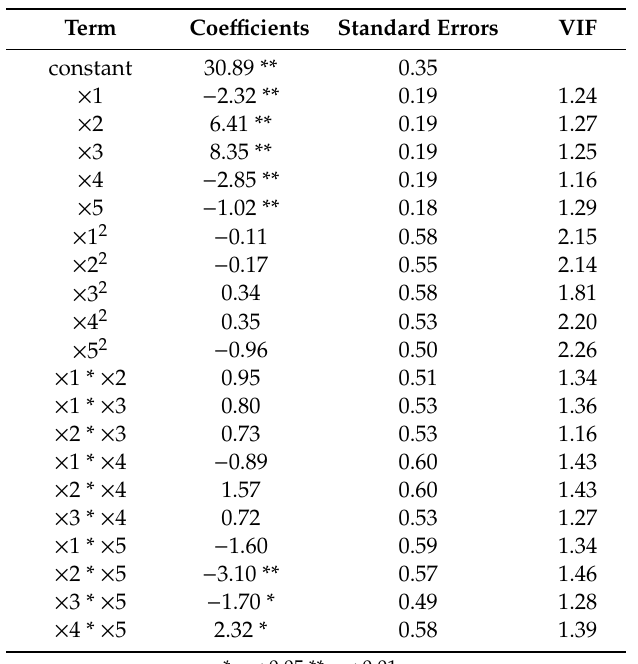
Table 4. The coe ffi cients of the terms in the regression model including interactions up to 2nd order. Term Coe ffi